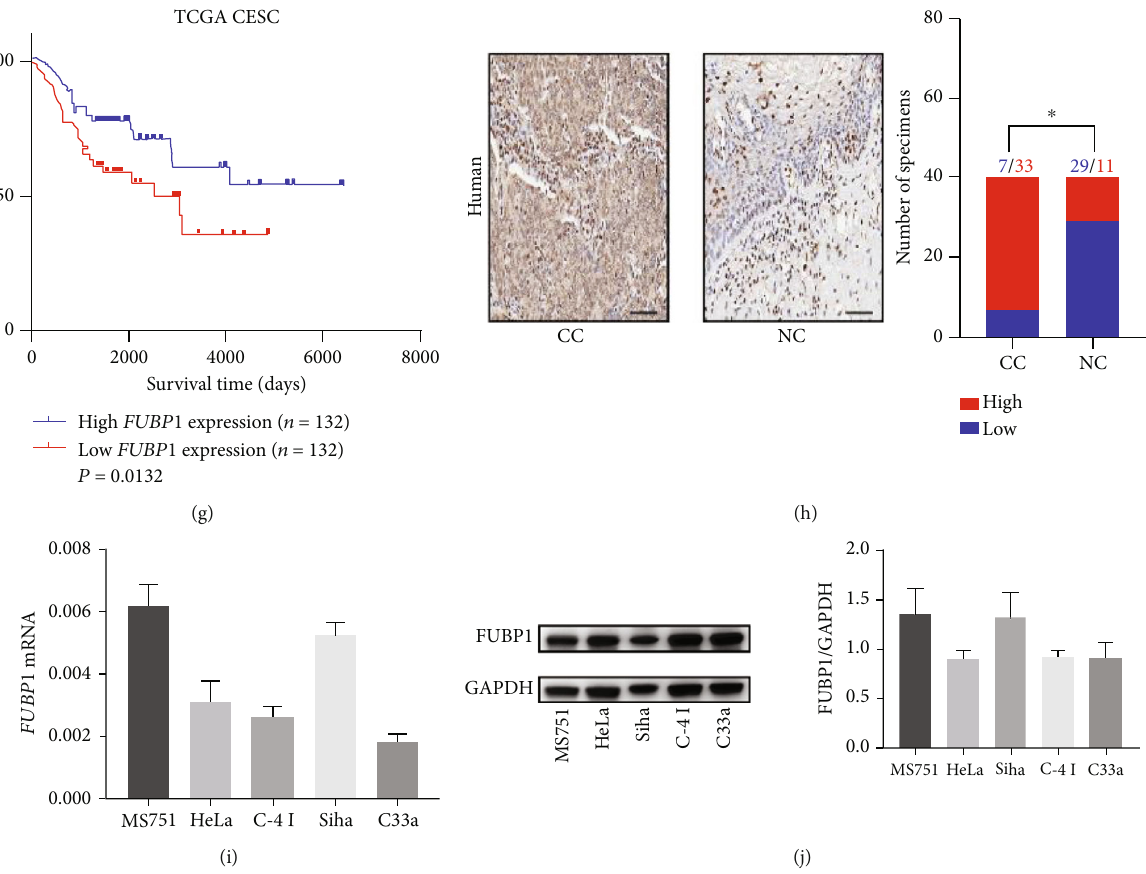
Figure 1: FUBP1 is upregulated and correlated with a poor prognosis in cervical cancer. (a) Analysis of FUBP1 genetic expression across various human cancers using TCGA databases. (b – e) Expression pro fi les of FUBP1 in cervical cancer (CC) and normal cervix (NC) samples from GSE6791 (b), GSE7410 (c), GSE7803 (d), and GSE9750 (e) datasets. (f) Expression pro fi les of FUBP1 in FIGO from TCGA databases. (g) Kaplan-Meier analysis of the overall survival of patients with FUBP1 high or low expression level. (h) Representative immunohistochemical images and quanti fi cation analysis showing FUBP1 expression in CC and paracarcinoma samples from the sixth hospital. (i, j) The mRNA (i) and protein levels (j) in di ff erent CC cell lines. Scale bar: 50 μ m. Two-tailed t -test, ∗ p < 0 : 05